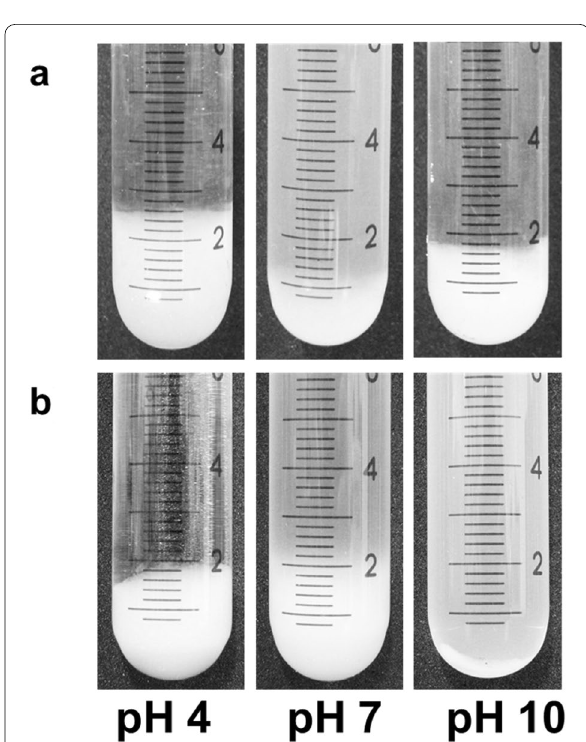
Fig. 6 Photographs of CNF suspensions after centrifugation at pH 4, 7 and 10: a unmodified CNFs, b